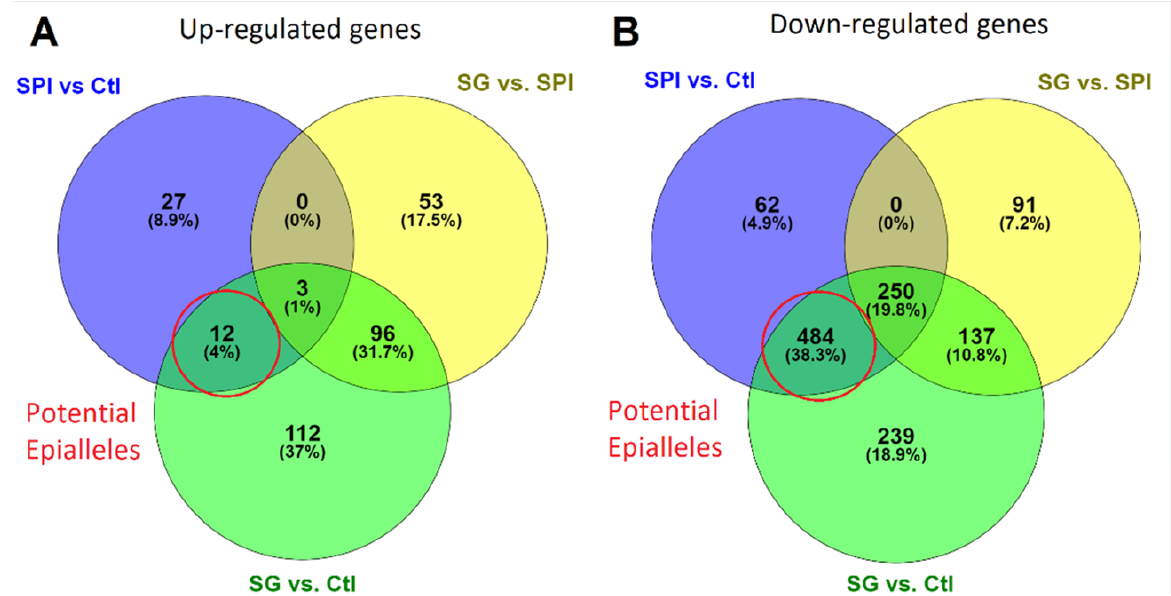
Figure 4. Venn diagram of the differentially expressed genes between three comparisons for upregulated ( A ) and downregulated genes ( B ). The number of differentially expressed genes of the first generation of larvae fed with and without SPIs (SPI vs. Ctl). The number of differentially expressed genes of the second generation (F1) compared to first generation of larvae fed on artificial diet with SPIs (SG vs. SPI) and without SPIs (SG vs. Ctl). We considered as potential epialleles the genes that were induced by SPIs and had the same response in the second generation of larvae fed a control diet without SPIs.